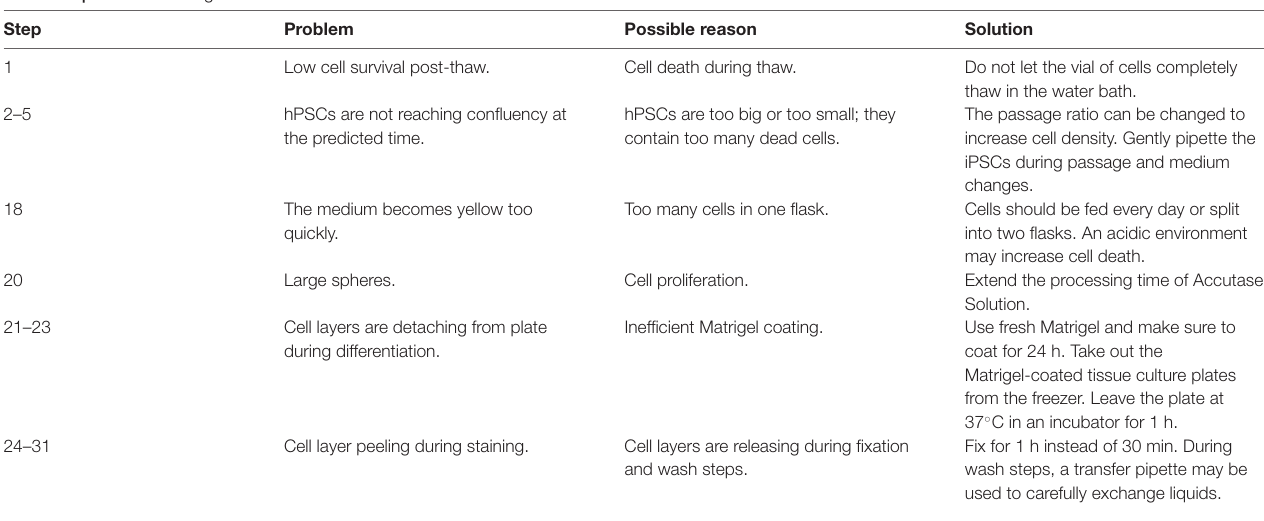
4 ◦ C overnight. Wash three times with 100 µ l of PBS for 15